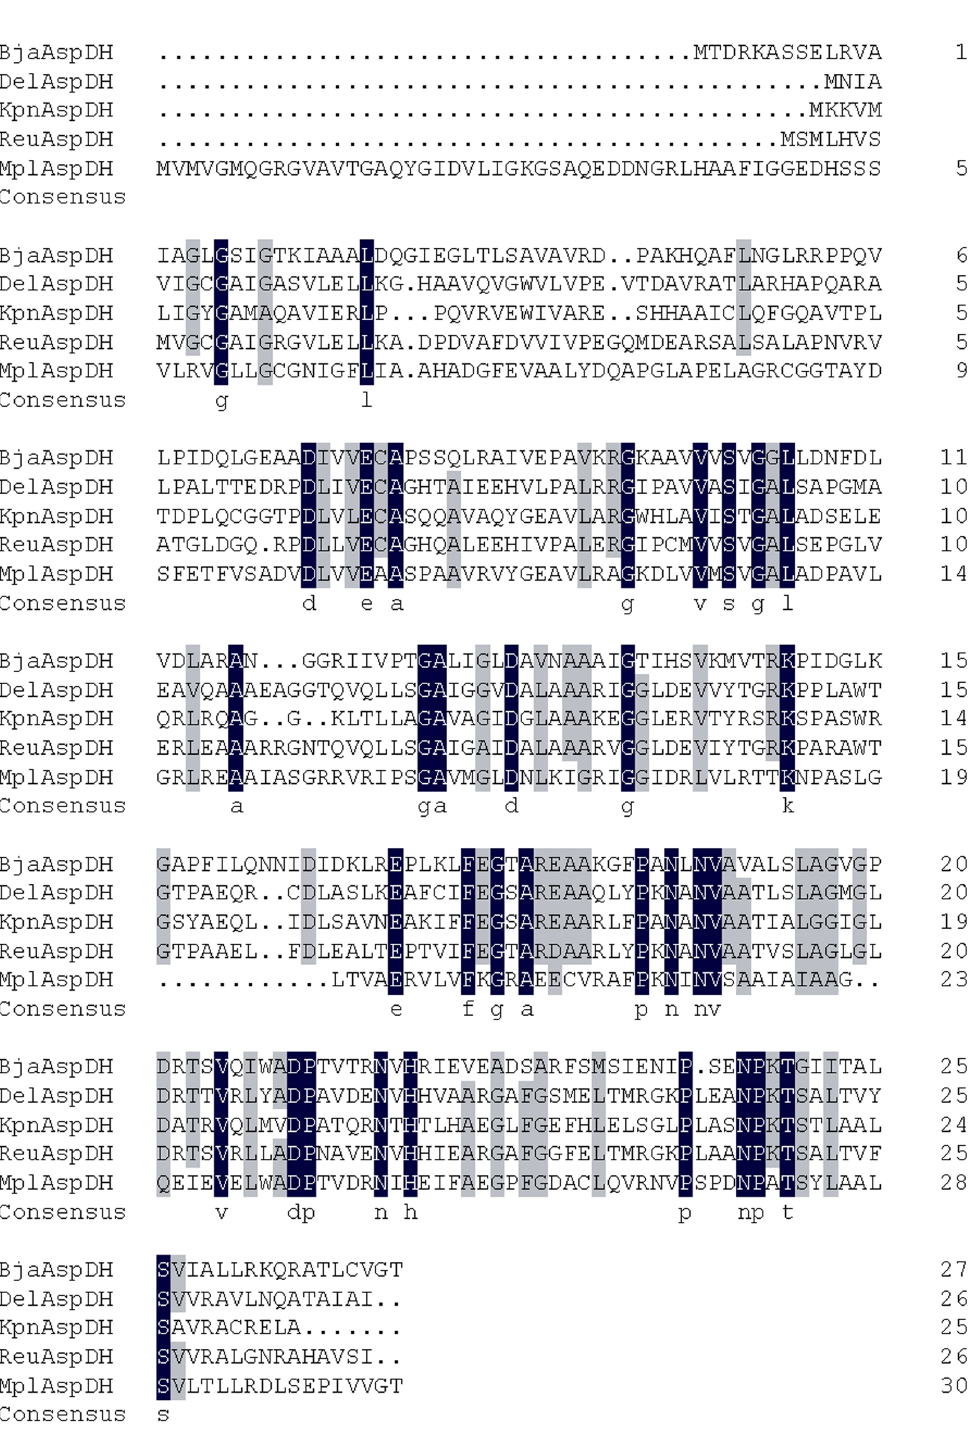
Figure 4. Multiple sequence alignments of aspartate dehydrogenases from Bradyrhizobium japonicum (BjaAspDH), Delftia sp. Cs1–4 (DelAspDH), Klebsiella pneumoniae 34618 (KpnAspDH), Ralstonia eutropha (ReuAspDH) and Methanosphaerula palustris